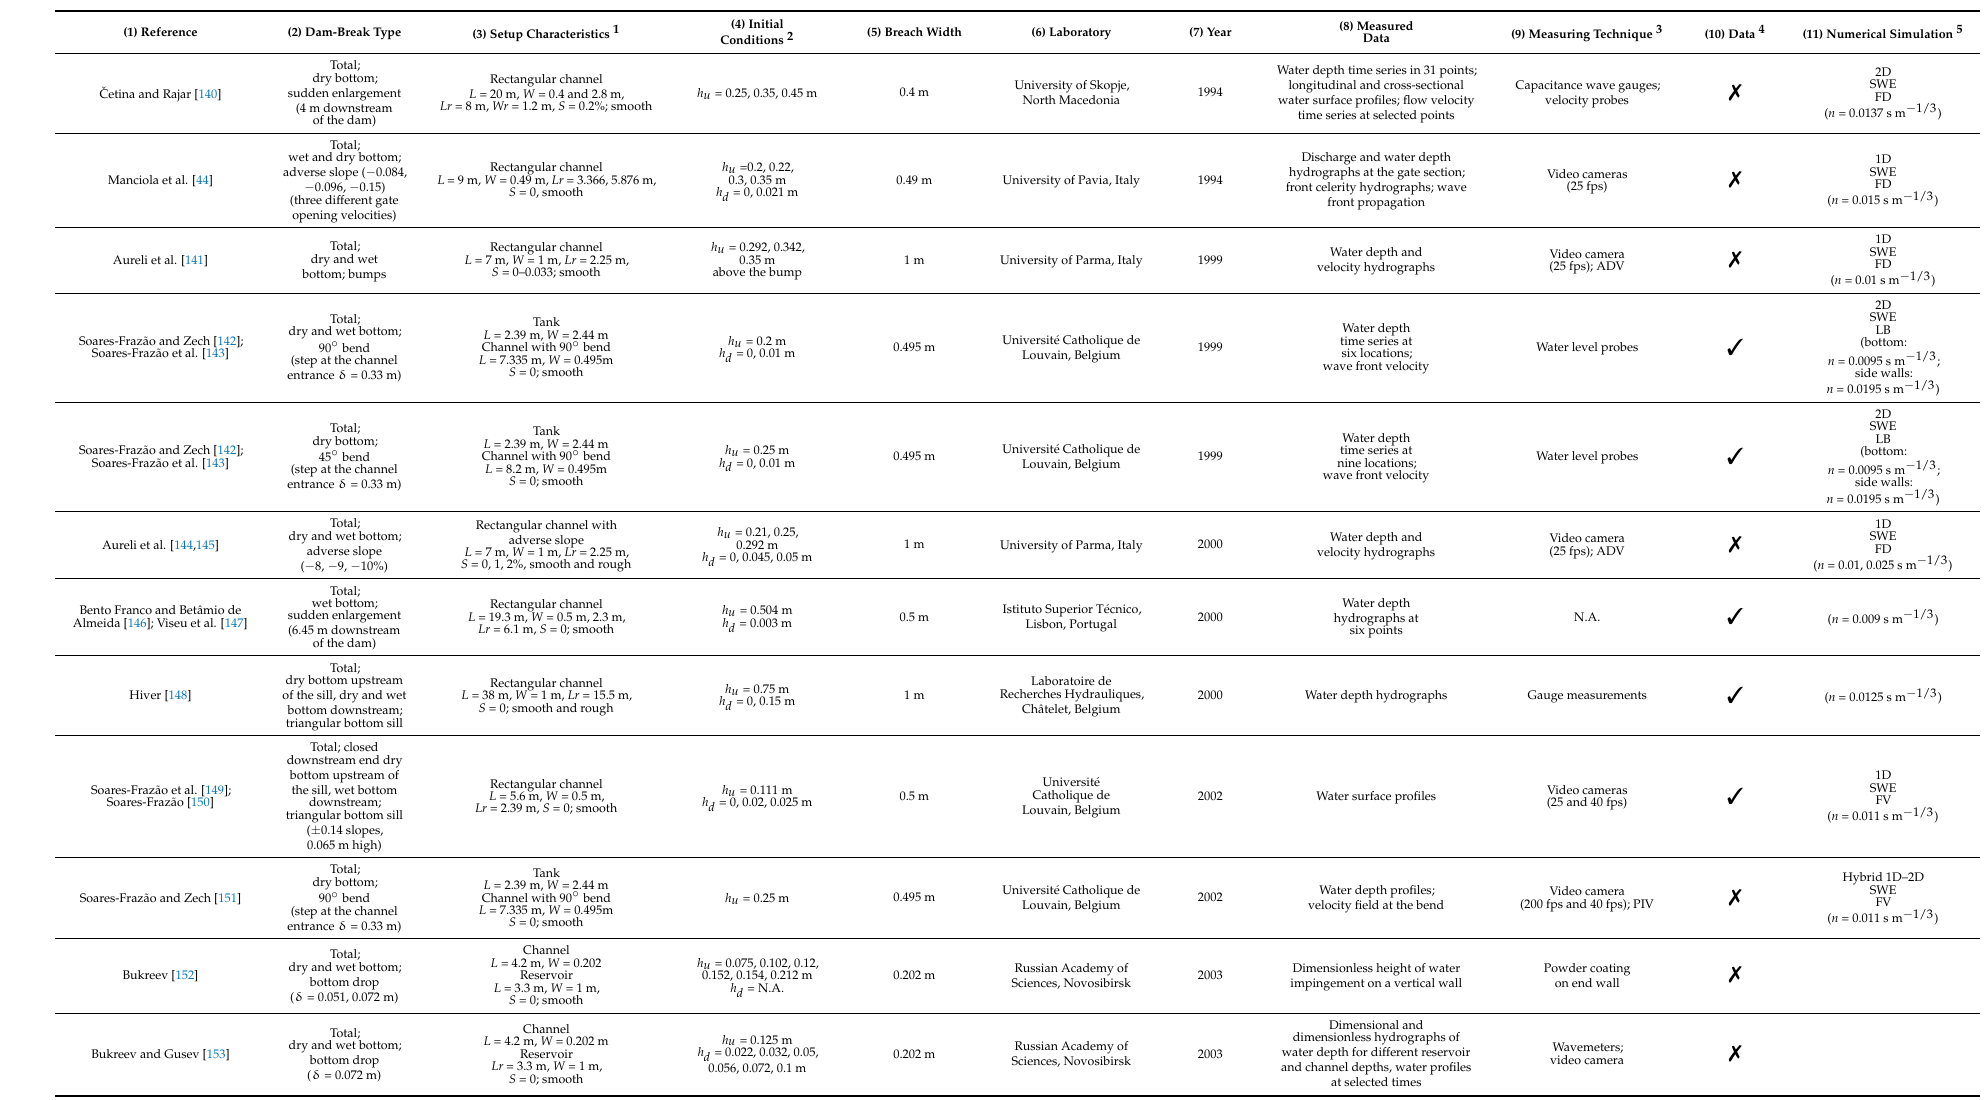
Table 1. Basic experimental investigations of fundamental dam-break wave physical characteristics.